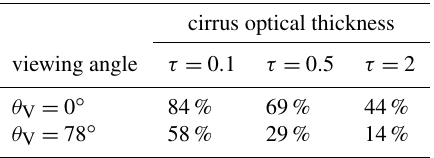
Table 1. Relative difference in I RTS , 1180nm for surface albedo α = 0 . 1 and α = 0 . 9 for different viewing angles θ V and optical thickness τ .